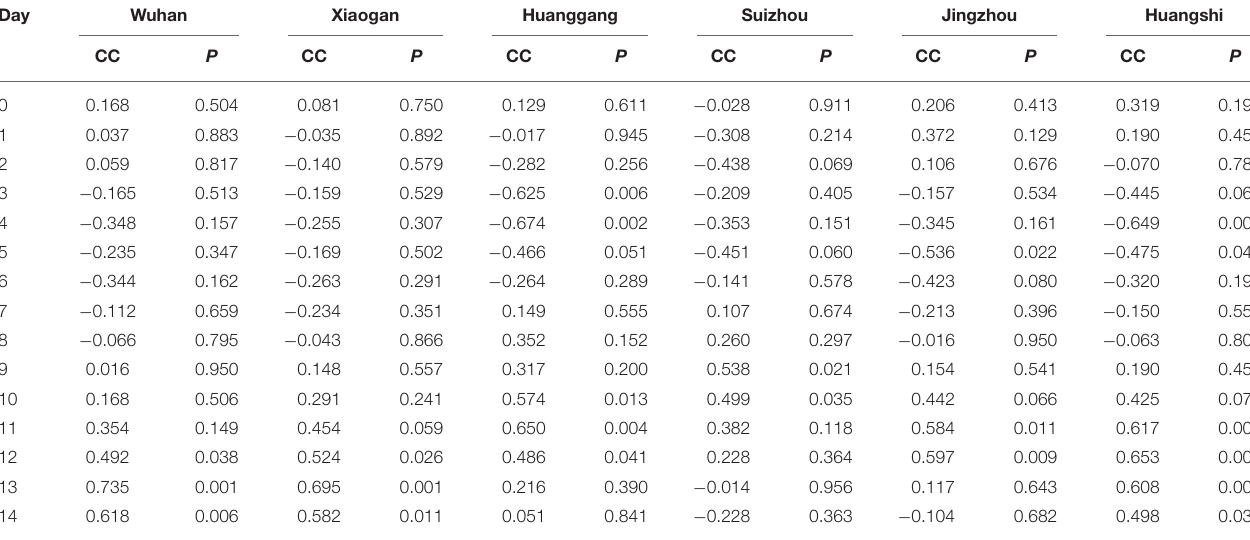
TABLE 2 | The correlations between the DNCC and daily minimum temperature 0–14 days prior to COVID-19 diagnoses in